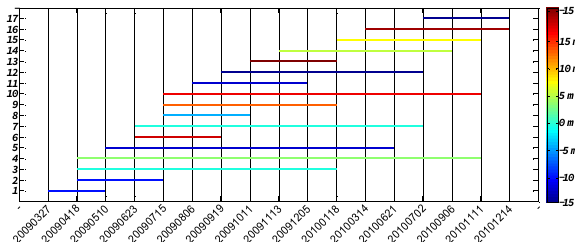
Figure 3. The spatial and temporal baselines of the 17 USB interferometric pairs used for TCP solution